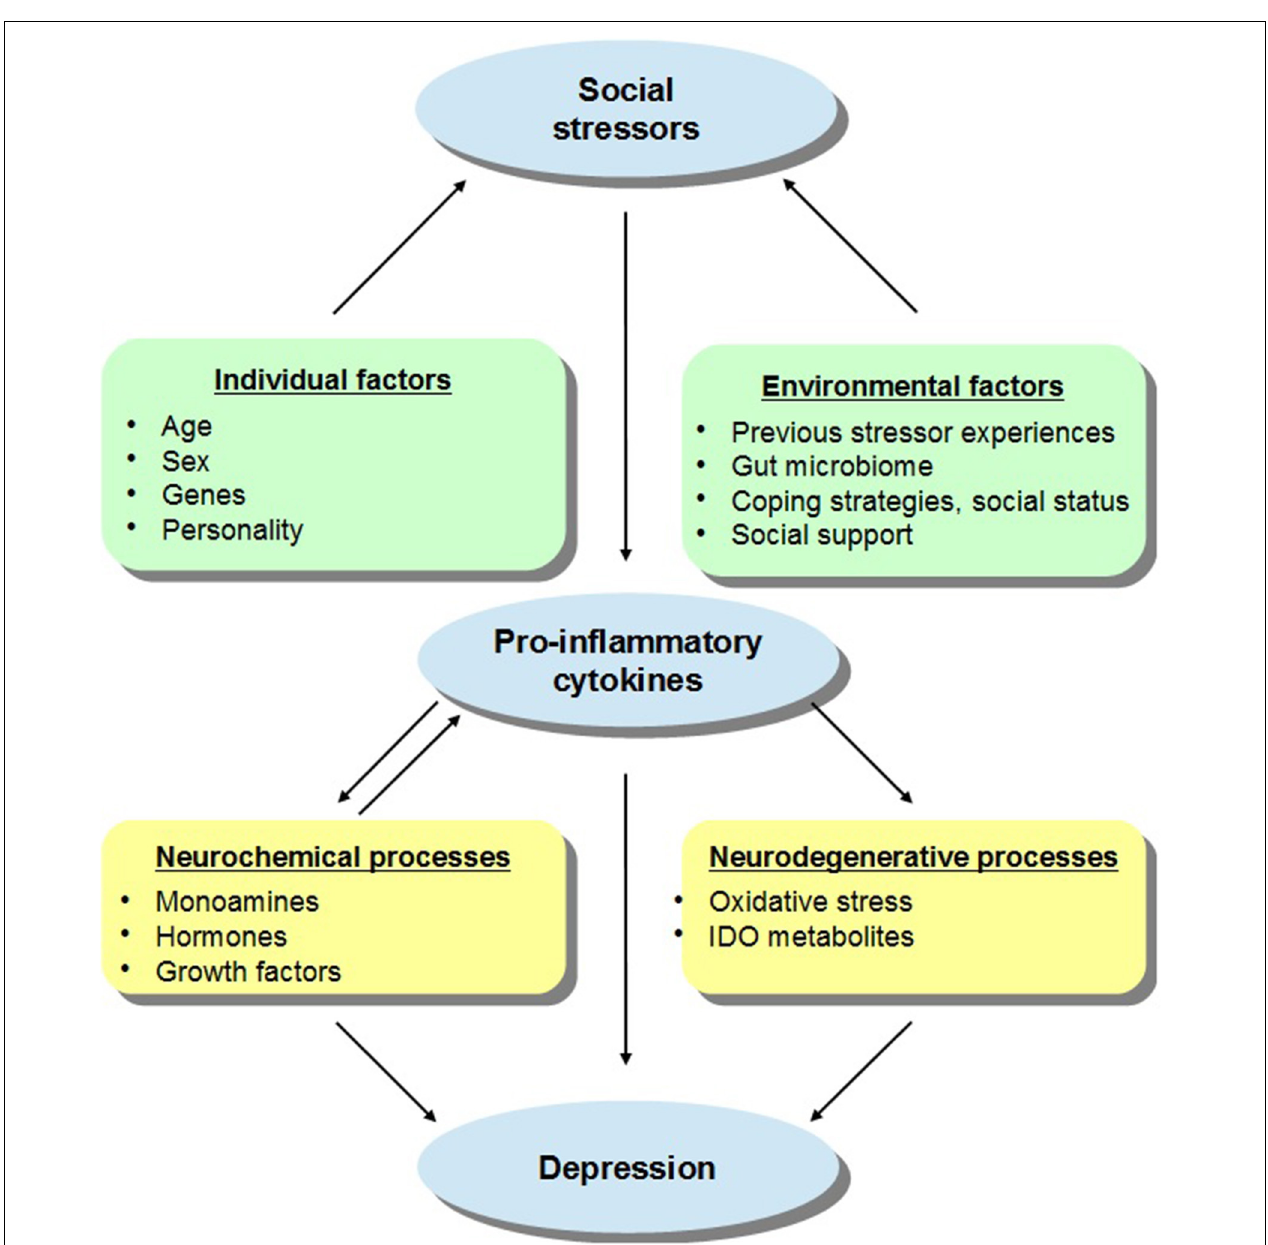
FIGURE 1 | A schematic representation of the relations between social stressors, pro-inflammatory cytokines, and depressive states, with a particular focus on the individual and environmental factors that may moderate these effects. It is suggested that in addition to sex and age, the capacity of social stressors to promote inflammatory variations that might lead to depression may be influenced by the presence of genetic and personality factors. For instance, individuals carrying specific gene combinations or polymorphisms (e.g., variants of IL-6, IL-1 β , TNF- α ) may be more vulnerable to the depressive effects of inflammatory activation provided that they also encounter social stressors. In addition, it is proposed that environmental factors may also impact on stress-related cytokine responses and thus on depressive symptoms. For example, previous stressor experiences in the form of prenatal or early-life adversity or immunological challenges as well as gut bacterial disturbances may